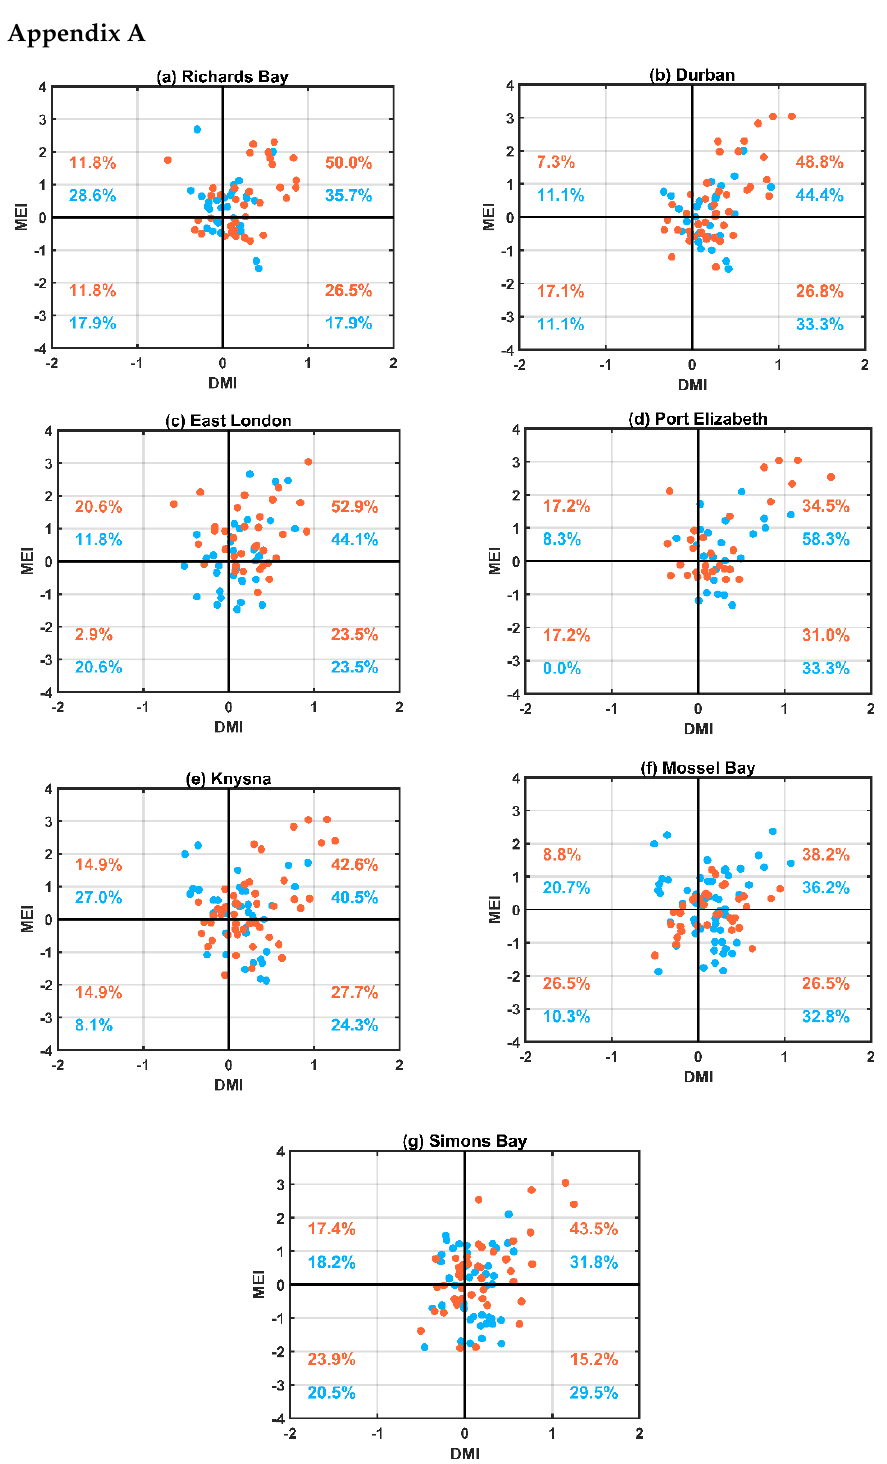
Figure A1. The MEI/DMI combinations in months with higher/lower (in red/blue) sea level than 1.5 standard deviations above/below mean sea level at ( a ) Richards Bay, ( b ) Durban, ( c ) East London, ( d ) Port Elizabeth, ( e ) Knysna, ( f ) Mossel Bay and ( g ) Simons Bay, respectively. The percentages indicate the number of months within a quadrant divided by the total number of the recorded SL months of the paired interactions.